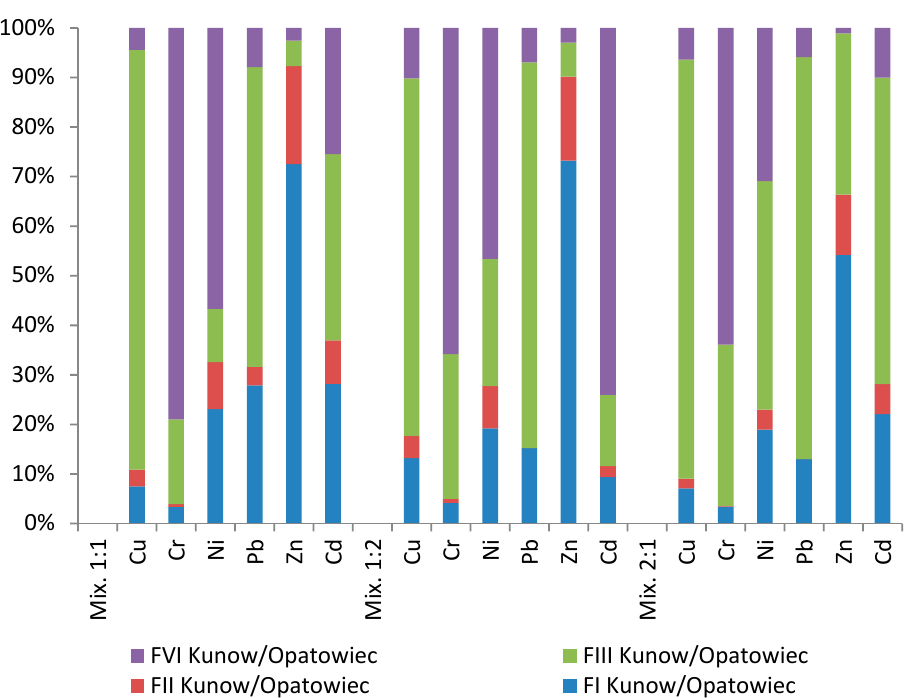
Figure 7. Percentage contents of heavy metals for particular fractions in Kunow–Opatowiec sludge– soil mixtures.